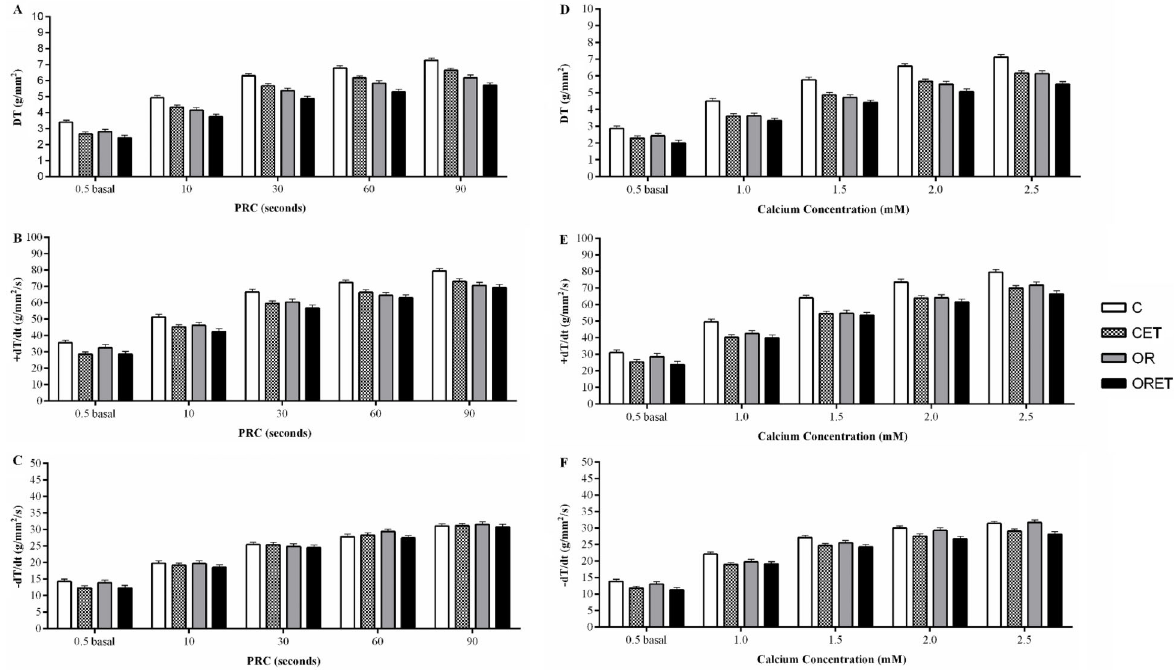
Figure 6. Mechanical properties of isolated papillary muscle from groups. A , B , and C , Post-rest contraction (PRC) and D , E , and F, elevation of extracellular Ca 2 + concentration (0.5 to 2.5 mM). Control group (C, n=12), control submitted to exercise training (CET, n=14), obese-resistant (OR, n=9), and obese-resistant submitted to exercise training (ORET, n=10). DT: maximum developed tension; + dT/dt: maximum rate of variation of the developed tension; -dT/dt: maximum rate of variation of the decrease in the developed tension. Data are reported as means ± SD. There were no statistically signi fi cant differences among groups (two-way repeated measures ANOVA followed by Bonferroni ’ s post hoc